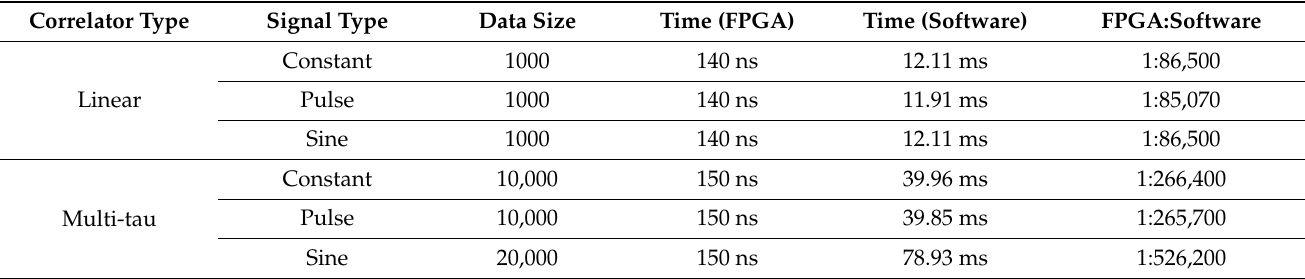
Table 4. Computation times of the FPGA and software correlators on the same sets of data. Correlator Type